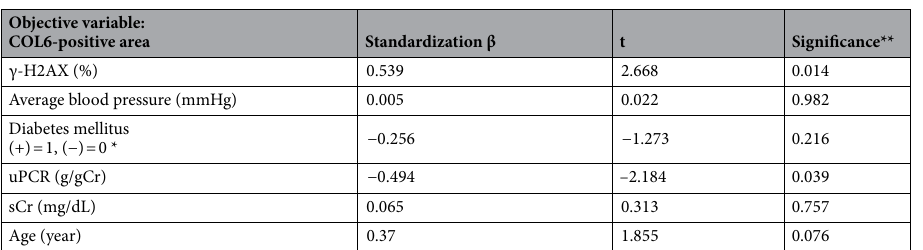
Table 3. Factors that influenced changes in Collagen type 6. Abbreviations: COL6; Collagen type 6, γ-H2AX; Histone H2AX phosphorylation on Serine 139, sCr; serum creatinine levels. Mean blood pressure was calculated as (systolic blood pressure-diastolic blood pressure)/3 + diastolic blood pressure. *Subjects with diabetes mellitus (DM) were classified as 1 and non-DM subjects as 0. **Factors were analyzed by a